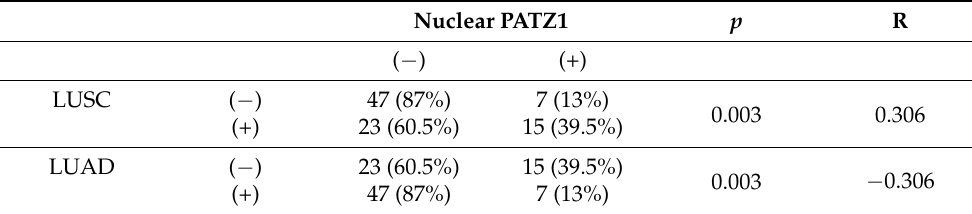
Table 3. Contingency table showing the correlation between PATZ1 nuclear expression and LUSC/LUAD subtypes 1 .